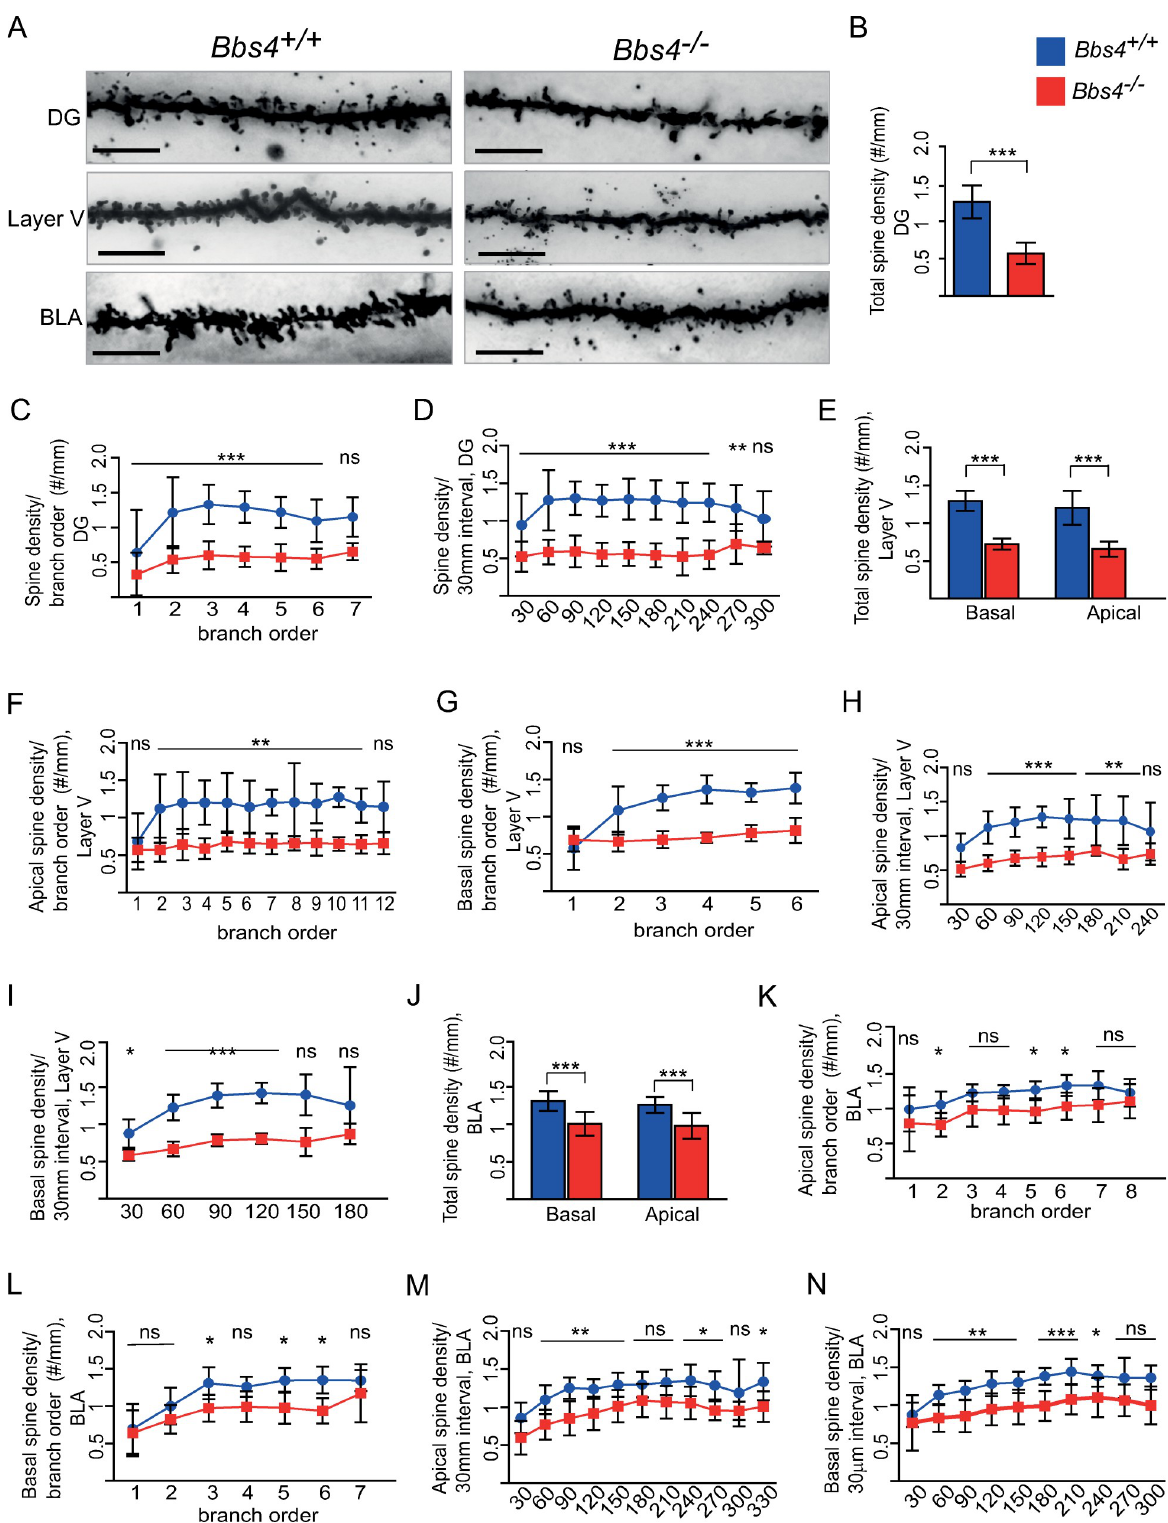
Fig 1. Dendritic spine morphology of DG, BLA, and frontal cortex neurons is affected by the loss of Bbs4 protein. (A) Representative images of Golgi-impregnated DG, BLA, and Layer V pyramidal neurons of P42 Bbs4 − / − and Bbs4 +/+ mice (100x; scale bar, 5 μ m). (B-D) Spine density of